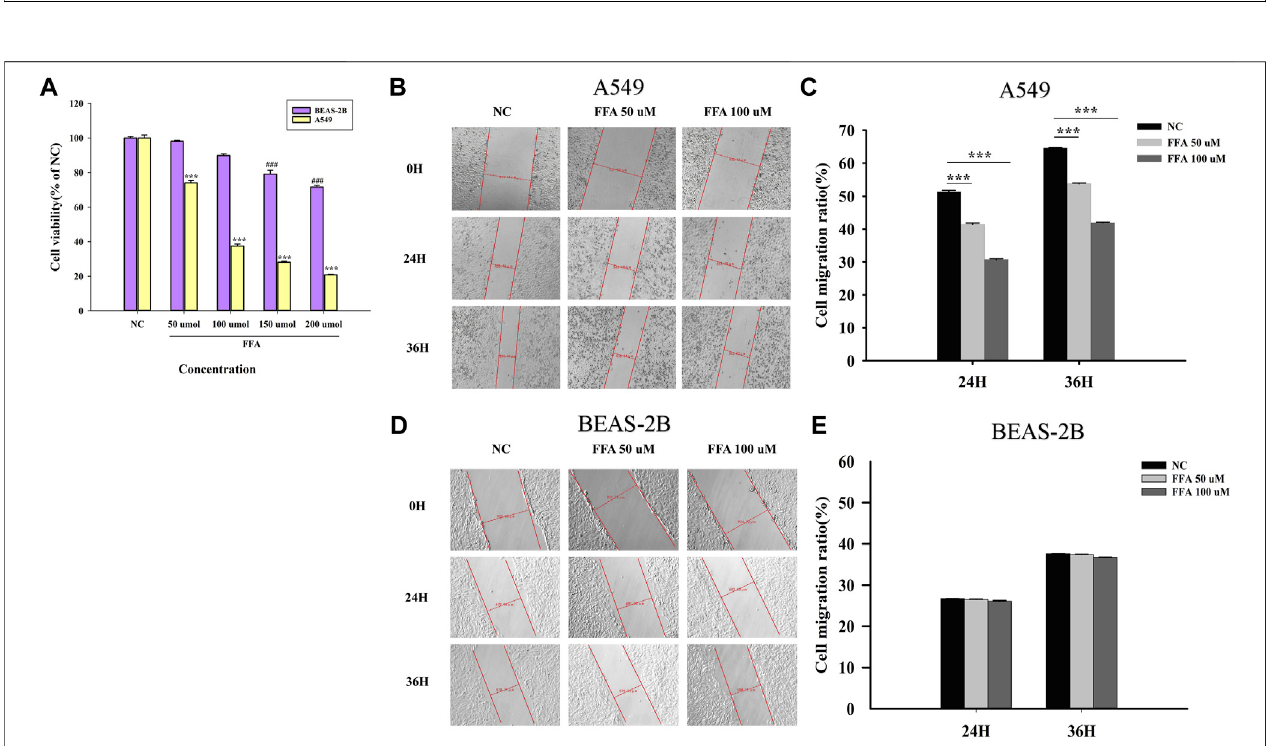
FIGURE 8 | Flufenamic acid inhibits cell viability and migration in A549 cells. (A) Effects of different concentrations of fl ufenamic acid on the cellular activity in A549 cells and BEAS-2B cells ( n = 5).*** p < 0.001 vs. NC of A549 cells. ### p < 0.001 vs. NC of BEAS-2B cells. (B) The scratch healing of A549 cells in different time periods. The scale bar is 50 μ m. (C) Statistical chart of cell migration ratio in A549 cells ( n = 3). *** p < 0.001 vs. NC. (D) The scratch healing of BEAS-2B cells in different time periods. The scale bar is 50 μ m. (E) Statistical chart of cell migration ratio in BEAS-2B cells ( n = 3). NC, negative control group.